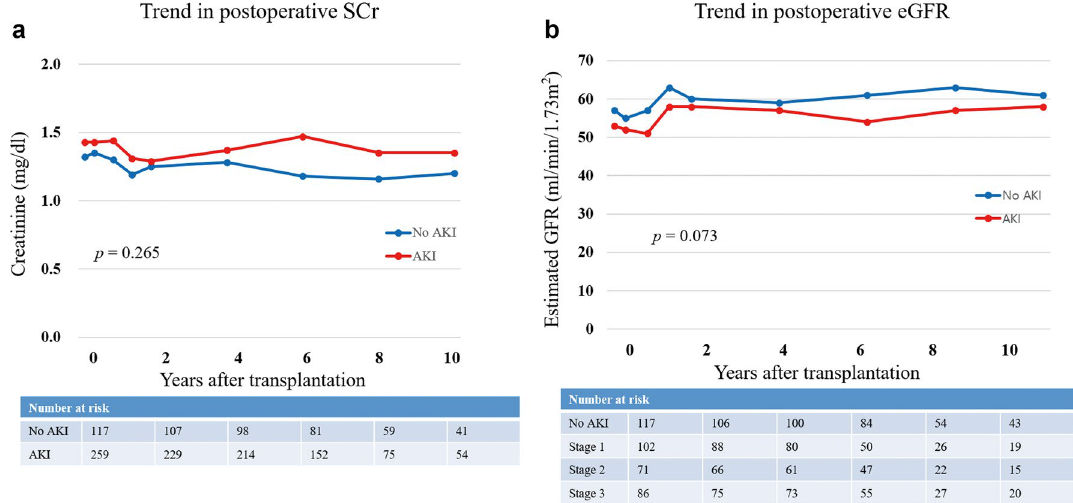
Figure 4. Trend in postoperative SCr and eGFR between the No AKI and AKI groups. ( a ) Trend in postoperative SCr stratified by the presence of AKI. Group comparisons were performed using a linear mixed model. ( b ) Trend in postoperative creatinine stratified by the presence of AKI. Group comparisons were performed using a linear mixed model. SCr serum creatinine, eGFR estimated glomerular filtration rate.